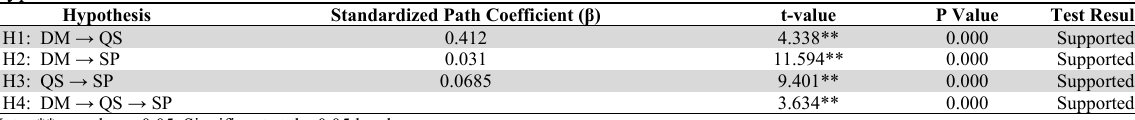
Hypothesis Result of the Structural